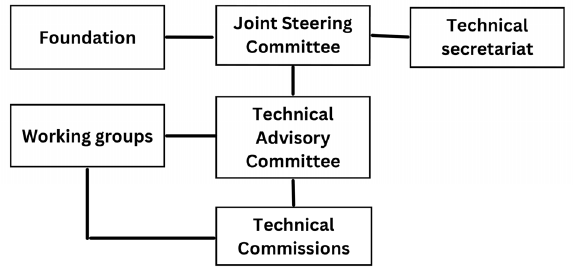
Figure 5. Organizational model for cross-border management in Mexicali B.C.-Imperial Valley.